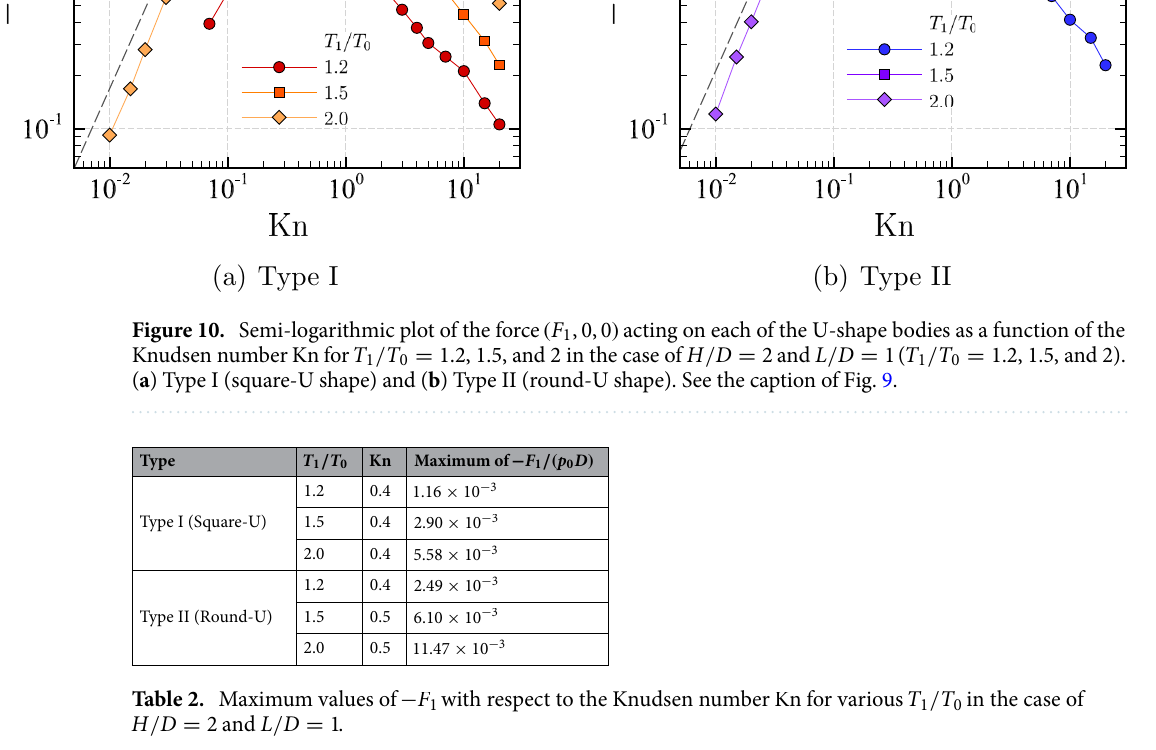
Table 2. Maximum values of H / D 2 and L / D =